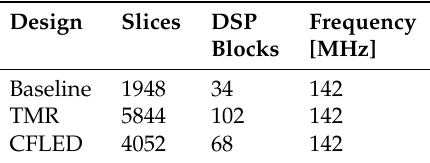
Table 4. Implementation